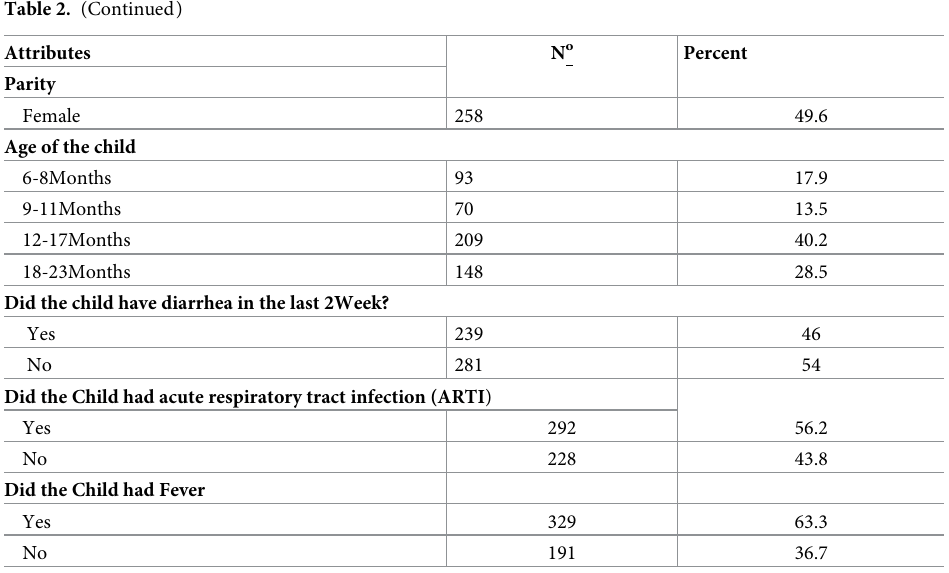
Note : Table 2 Maternal obstetric related characteristics of mothers of children 6–23 month old age.